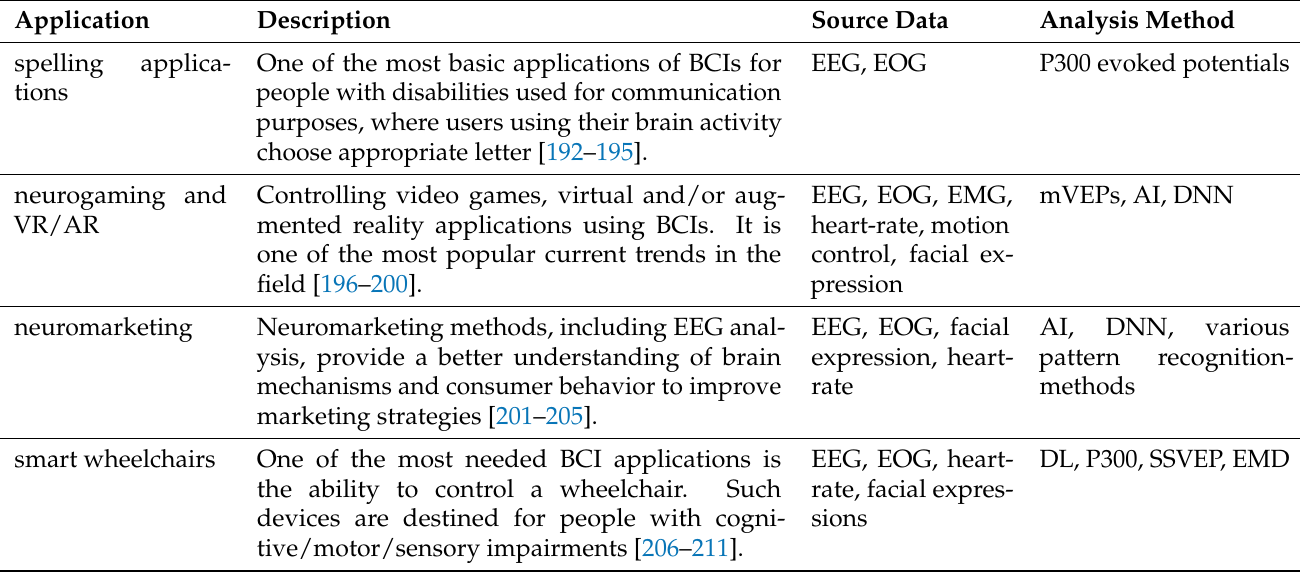
Table 4. The summary of the most popular BCI